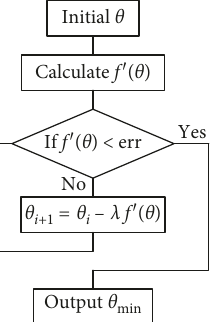
Figure 7: Flowchart of the gradient descent method.